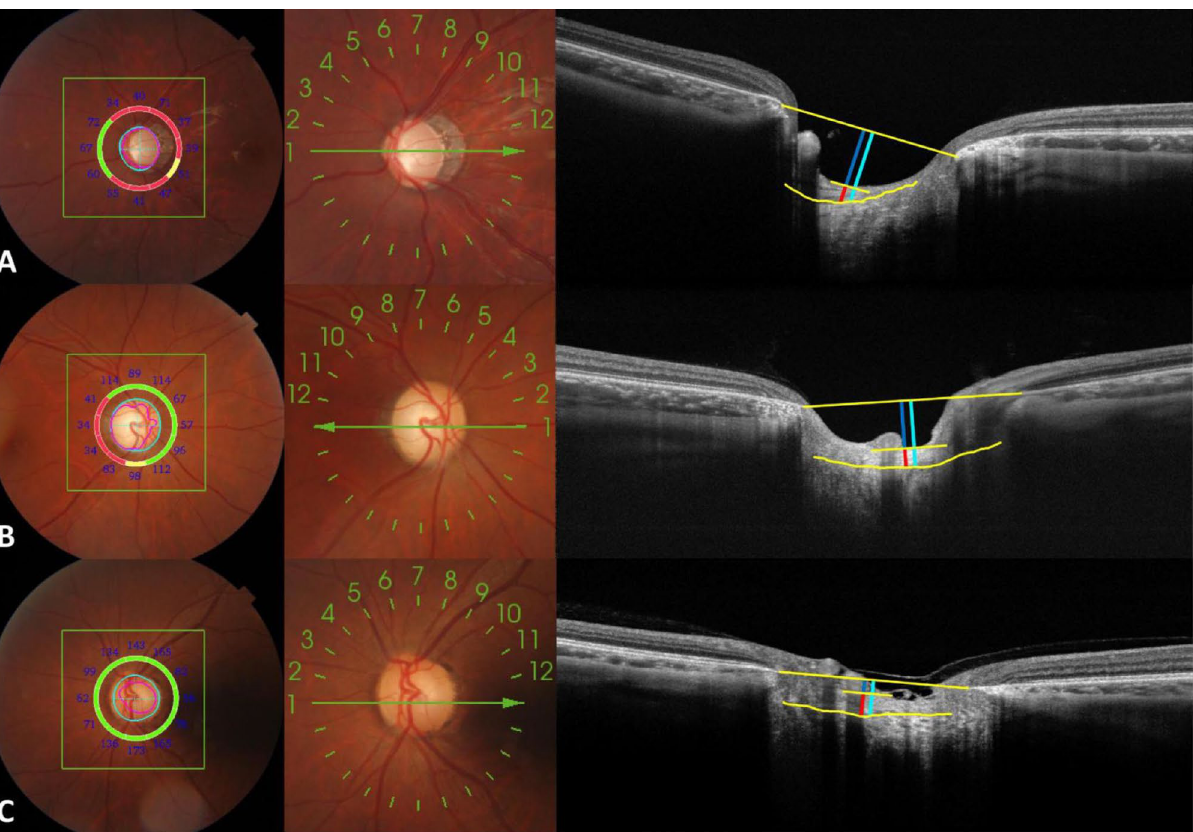
Figure 4. Fundus images and optic disc OCT images in typical cases. ( A – C ) showed the fundus and optic disc structure images of a patient with high IOP (group A, IOP = 39.9 mmHg), a patient with moderate IOP (group B, IOP = 24.3 mmHg) and a normal subject (Group C, IOP = 14.3 mmHg). It can be seen that the higher the IOP level, the more serious the defect of optic nerve channel around the optic disc, the higher the C / D ratio, the deeper the CD and LCD on the OCT image, In addition, the curvature of lamina cribrosa increases only for the rough observation on the image. (long yellow line: BMO line on both sides; yellow curve: front surface of sieve plate; dark blue line: CD; light blue line: LCD; red line: